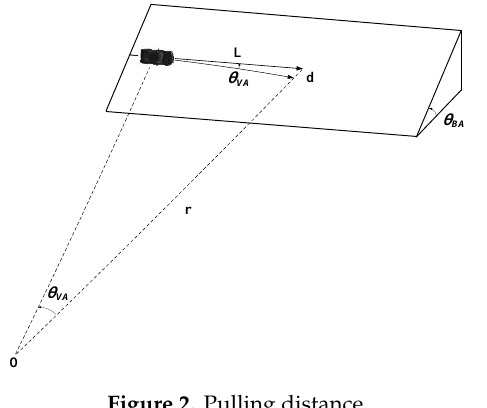
Figure 2. Pulling distance . Figure 2. Pulling